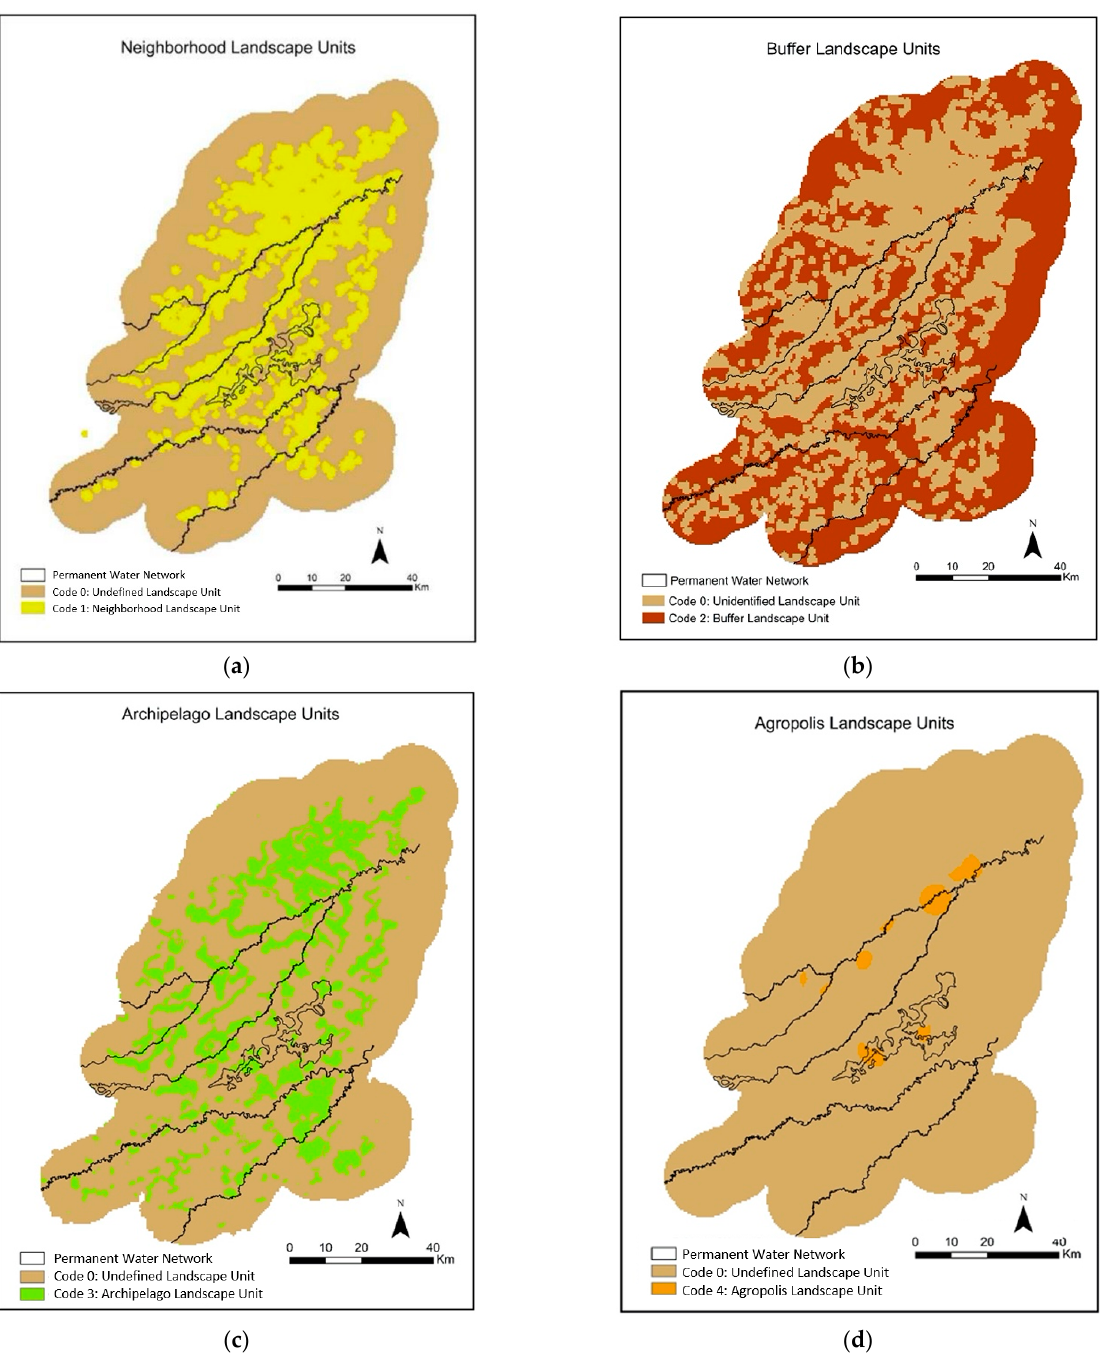
Figure 5. ( a ) Neighborhoods are defined as all areas of the landscape within 1 km of a raised field of any size. ( b ) Buffer landscape units represent all areas of the landscape with a combined distance of at least 3 km to the nearest forest island and neighborhood but are still not within 1 km of either a forest island or raised field neighborhood. ( c ) Archipelago landscape units represent all areas of the landscape that meet three sets of criteria: located within 1 km of a seasonal stream, within 2 km of a raised field neighborhood containing less than 90 individual platforms, and within 2 km of a small forest island less than or equal to 0.8 ha in size. ( d ) Agropolis landscape units represent all areas of the landscape that meet three sets of criteria: located within 4 km of a permanent water network, within 2 km of a large raised field neighborhood containing more than 90 individual platforms, and within 4 km of a large forest island greater than or equal to 22.6 ha in size.